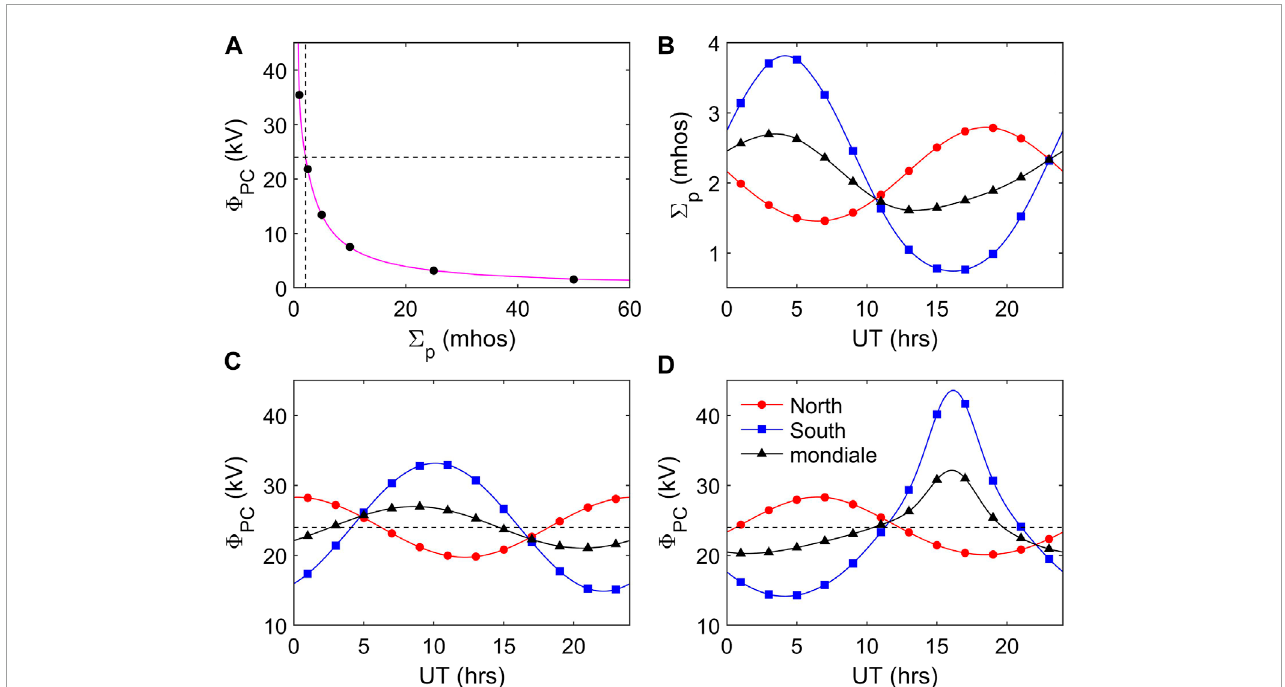
FIGURE 21 Comparison of the basic predictions of the pole motion and conductivity mechanisms. (A) Shows the dependence of transpolar voltage Φ PC on the polar cap Pedersen conductivity Σ p found from numerical simulations by Ridley et al. (2004) (their Figure 1B). (B) Shows the UT variations of the average polar cap Pedersen conductivity Σ p from Figure 6 ). (C) . The transpolar voltage for a daily mean of 24 kV caused by pole motions (from Figure 5B ) and (D) the transpolar voltage change caused by the conductivity changes in part (B) , scaled using the variation in part (A) to a daily mean of 24 kV as in (C) . Red lines with red circle symbols are for the northern hemisphere, blue lines with blue square symbols for the southern hemisphere and black lines with black triangle symbols are the global (mondiale) values obtained by averaging the two.